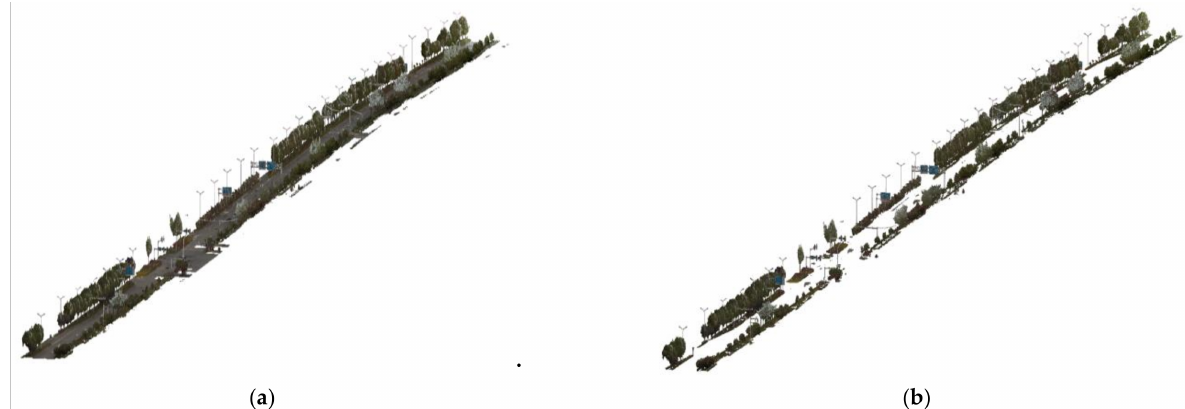
Figure 13. Comparison of cloud data of the road scene before and after filter; ( a ) is before the filter, and the ( b ) is after the